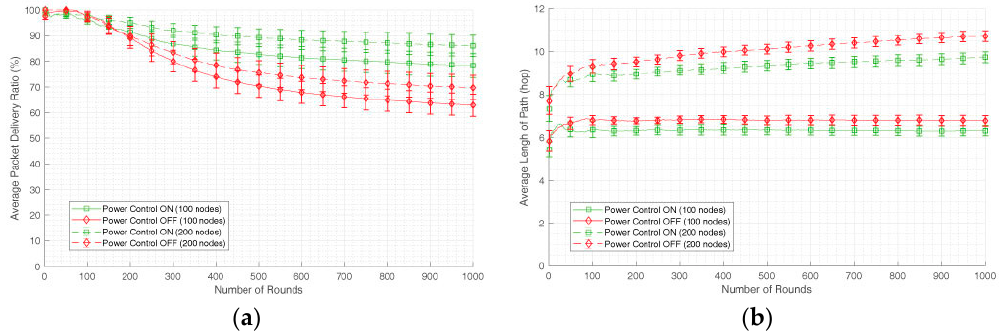
Figure 3. Network performance in terms of ( a ) average packet delivery ratio and ( b ) average length of path.